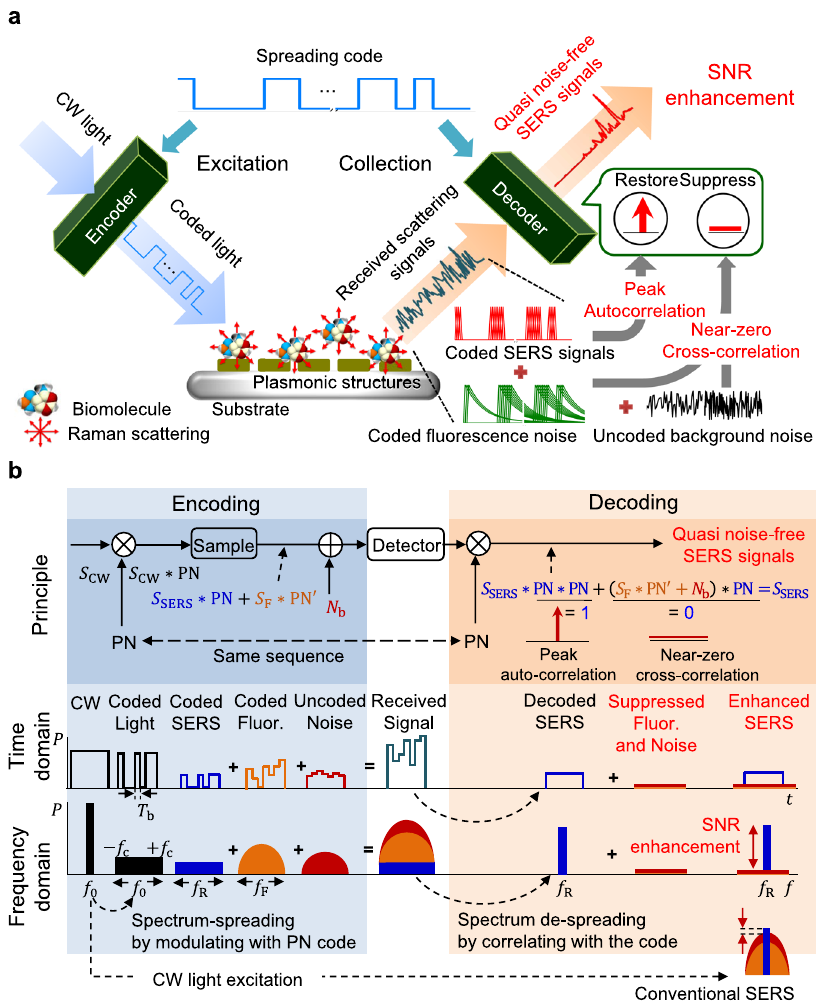
Fig. 1 Conceptual description of spread spectrum SERS (ss-SERS) detection with spreading coded light excitation. a Schematic illustration of ss-SERS detection with coded light excitation. A laser beam is encoded by using a spreading code of pseudorandom noise (PN) and is injected on a SERS substrate with Raman active molecules, where the SERS signals are simultaneously encoded with the coded excitation of light. Noise-suppressed SERS signals are reconstructed at the decoder by using peak autocorrelation between the spreading code and the coded SERS signals, whereas all noise, including fl uorescence and background noise, is effectively eliminated due to a near-zero cross-correlation between the spreading code and the noise. b Encoding and decoding principles for the removal of background noise and the restoration of noise-suppressed SERS signals. S CW , S SERS , S F , and N b represent the CW light excitation, original SERS signals, original fl uorescence signals, and background noise signals, respectively. PN is the PN code used in the encoding process and PN ′ is a distorted pattern from PN. The bit duration ( T b ) and the modulation frequency ( f c ) are inversely proportional. P , t , and f represent the signal power, time, and frequency, respectively. In the time domain, the coded light and the coded SERS signals exhibit pulse sequences of the same pattern as the PN code of the encoding process, whereas the fl uorescence signals are encoded in a distorted pattern from the PN code due to the lifetime of the fl uorescence signals being longer than the bit duration. Consequently, the coded fl uorescence and background noise are completely fi ltered out by correlating with the PN code of the encoding process due to the spectrum-spreading property of the spreading code, resulting in an exceptional SNR continuous wave (CW) light ( S CW ) and original SERS signal signals are spread out in the frequency domain, where all the ( S SERS ) convoluted with the PN code (PN). The fl uorescence noise is added (the bottom of Fig. 1b). The decoding process, i.e., signal ( S F ) is encoded in a distorted pattern (PN ′ ) from the spectrum de-spreading, is a series of operations that reduces the spreading code because the lifetime of the fl uorescence signal is noise and restores the quasi-noise-free SERS signals. The original longer than the bit duration at the modulation frequency; the SERS signals are exactly reconstructed during the decoding pro- coded fl uorescence signal is represented as S F ∗ PN ′ . The back- cess by using the peak autocorrelation of the spreading code and ground noise ( N b ) is added to both the coded SERS signals and the coded SERS signals. The reconstruction process is mathe- the coded fl uorescence signals, and then all the signals are matically expressed as S SERS ∗ PN ∗ PN = S SERS because PN ∗ PN = 1 is attributed to the peak autocorrelation of the spreading delivered to the detector ( S SERS ∗ PN + S F ∗ PN ′ + N b ). In the time domain, the coded light and coded SERS signals are repre- code. All noise, including the fl uorescence signals, is effectively sented as the same pattern as the PN code during the encoding eliminated due to near-zero cross-correlation with the PN code process. Due to the spectrum spreading properties of the PN (( S F ∗ PN ′ + N b ) ∗ PN = − 1/ N ≈ 0), where N is the code length. Unlike the encoding process, only noise is spread out during the code, coded light, and coded SERS signals, the coded fl uorescence